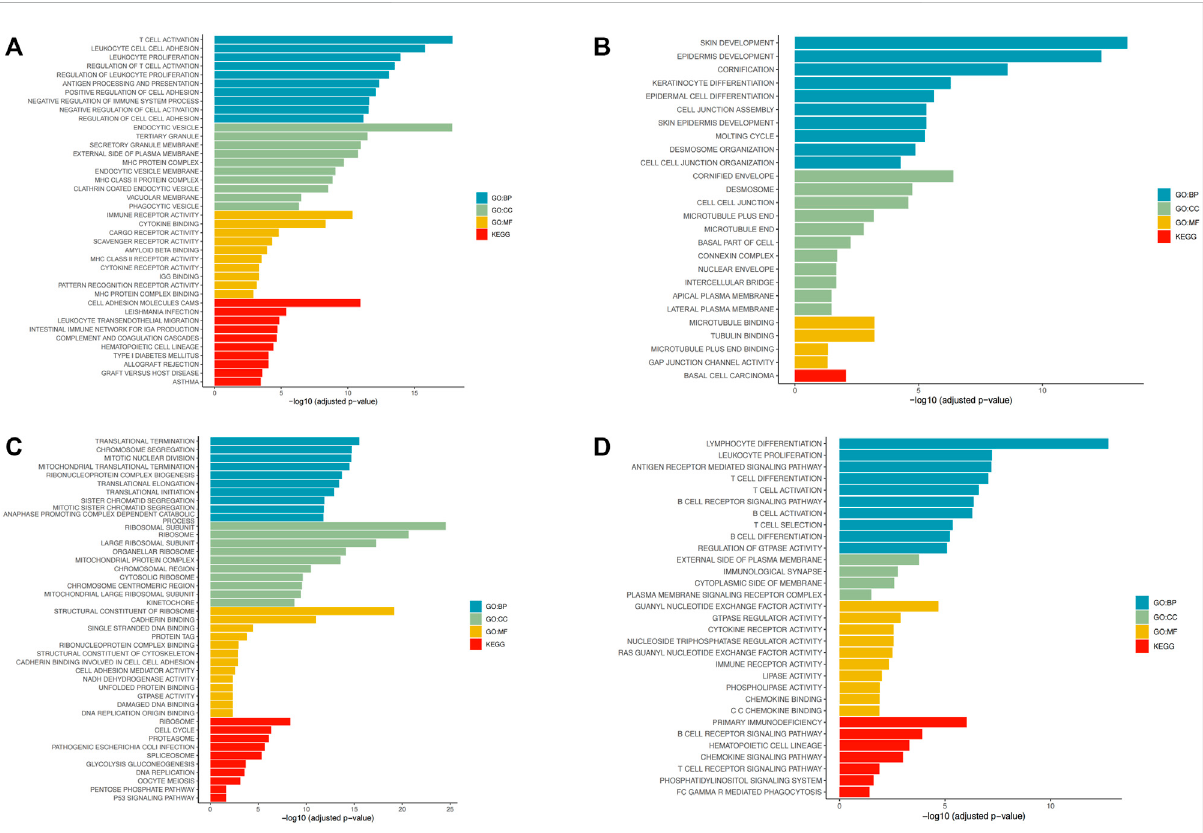
FIGURE 6 Pathway enrichment analysis using R ’ s cluster pro fi ler. (A) Enrichment of positive correlation gene pathways in lung squamous cell carcinoma. (B) Enrichment of negative correlation gene pathways in lung squamous cell carcinoma. (C) Enrichment of positively correlation gene pathways in lung adenocarcinoma. (D) Enrichment of negative correlation gene pathways in lung